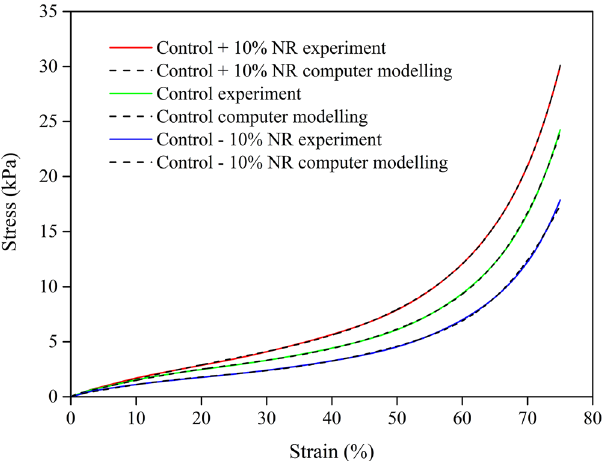
Figure 3. Compression stress–strain curves of foam samples from the experimental data and the computation of the 6th order reduced polynomial model.